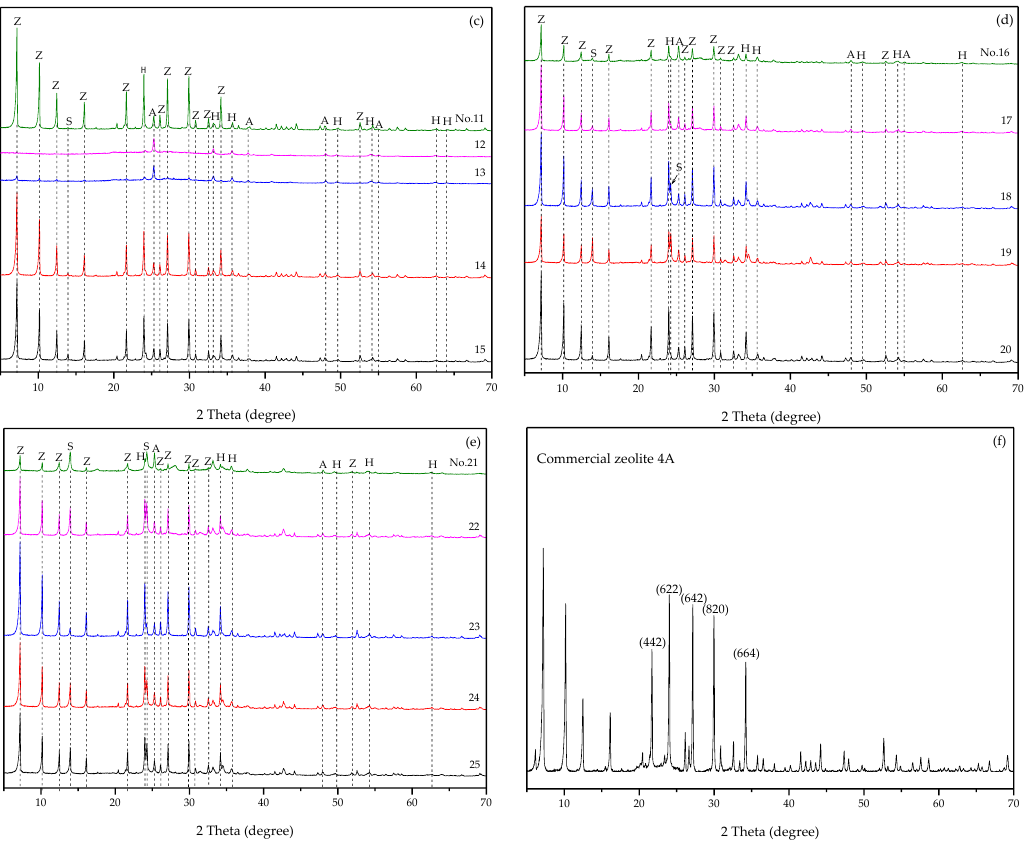
Figure 4. XRD patterns of the samples synthesized at different temperatures: ( a ) 50 °C, ( b ) 70 °C, ( c ) 90 °C, ( d ) 110 °C, and ( e ) 130 °C , and ( f ) commercial 4A zeolite. (Z: 4A zeolite, A: anatase, H: hematite, and S: sodalite).